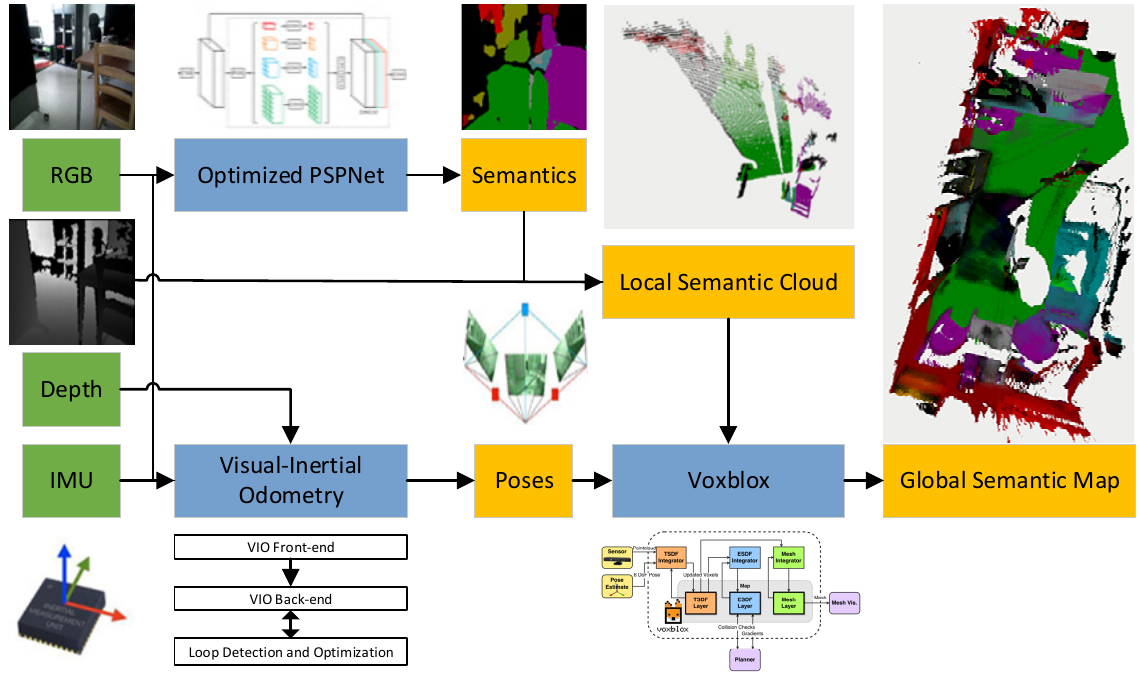
Figure 1. The architecture of CDSFusion. The green box is the input data, the blue box represents three modules of CDSFusion and the yellow box is output of the modules.